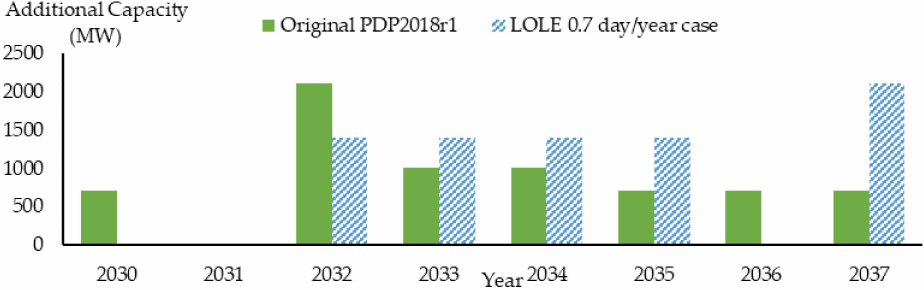
Figure 10. Additional generation capacity of the PDP2018r1 and the case of LOLE 0.7 day/year.